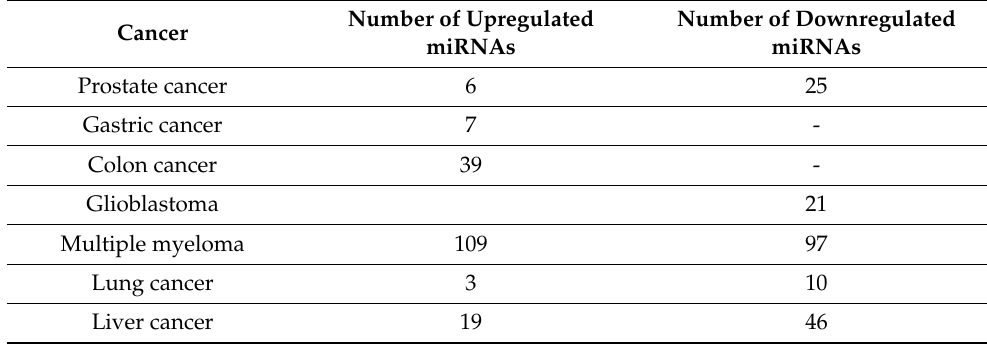
Table 1. Results summary of exosomal miRNA expression in seven cancer datasets (patients vs. controls).